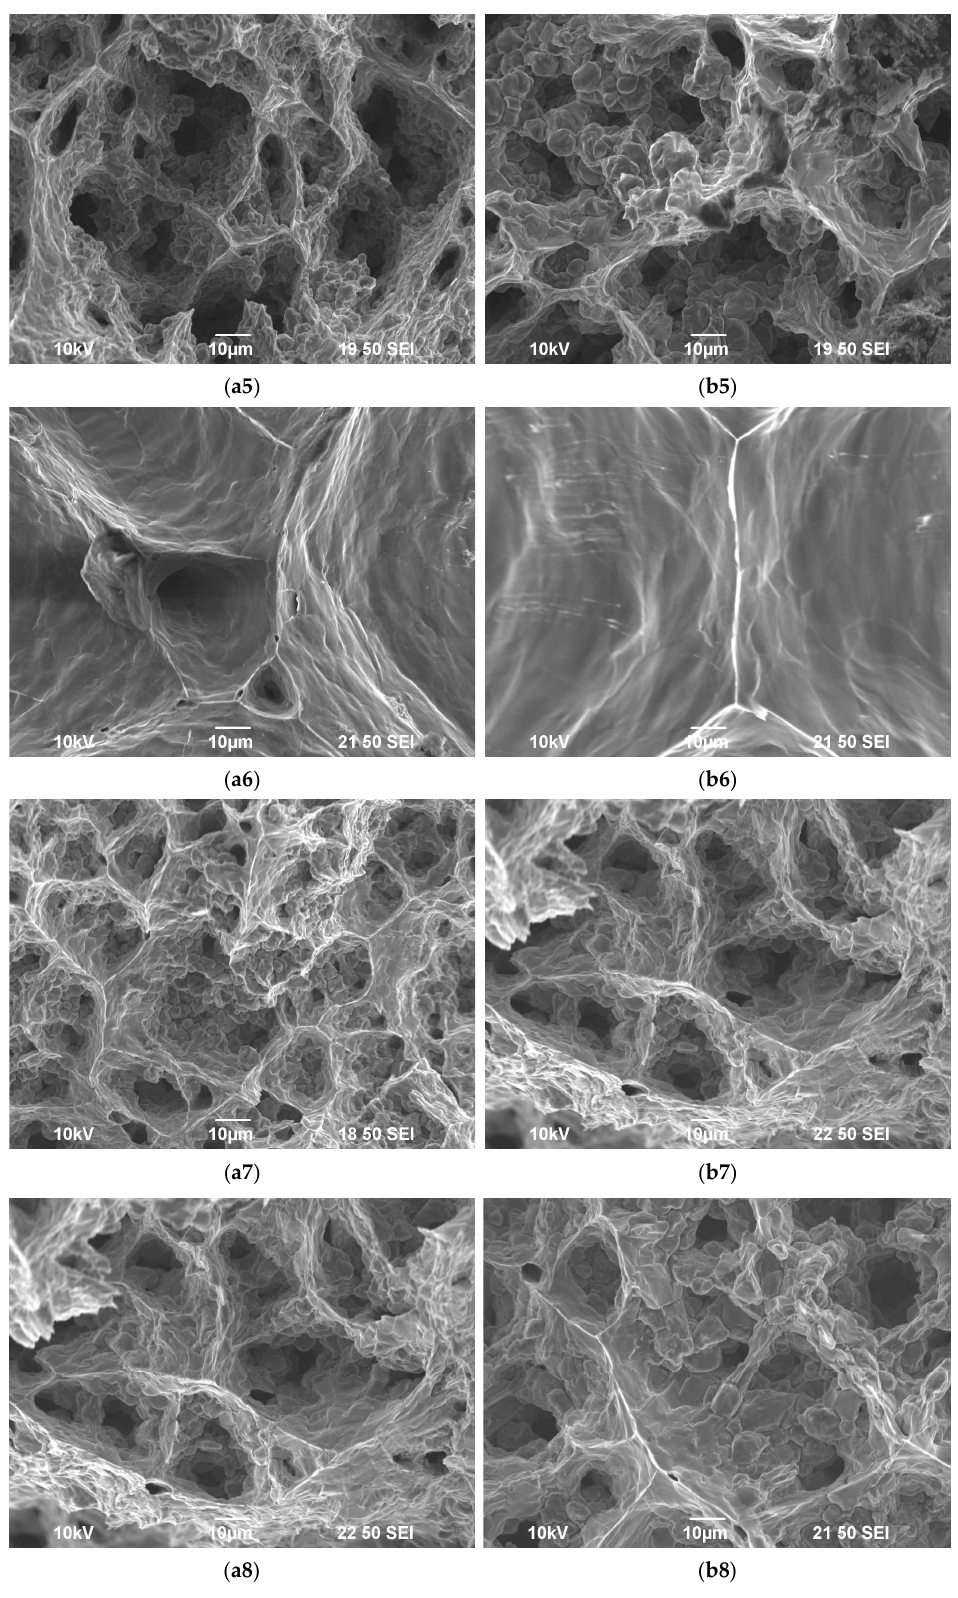
Figure A4. Central part of fractures in UFG alloy specimens No. 1 ( a1 , b1 ), 2 ( a2 , b2 ), 3 ( a3 , b3 ), 4 ( a4 , b4 ), 5 ( a5 , b5 ), 6 ( a6 , b6 ), 7 ( a7 , b7 ), and 8 ( a8 , b8 ) after tensile tests at 400 °C ( a1 – a8 ) and 500 °C ( b1 – b8 ). Strain rate of 3.3 × 10 − 3 s − 1 .